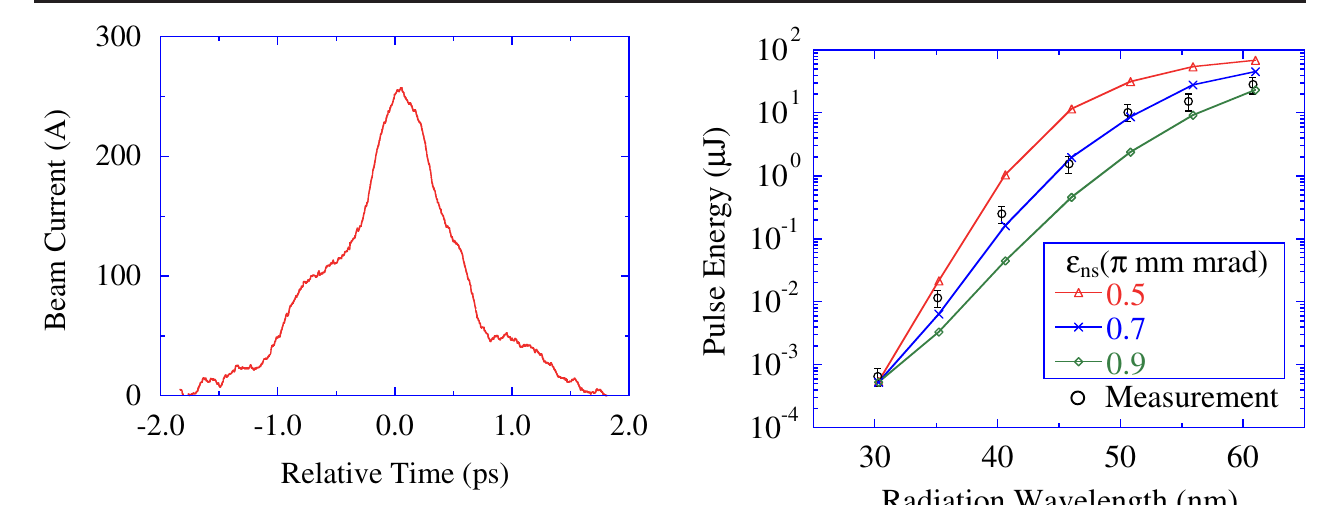
FIG. 14. (Color) Relation between (cid:7) the experimental results.